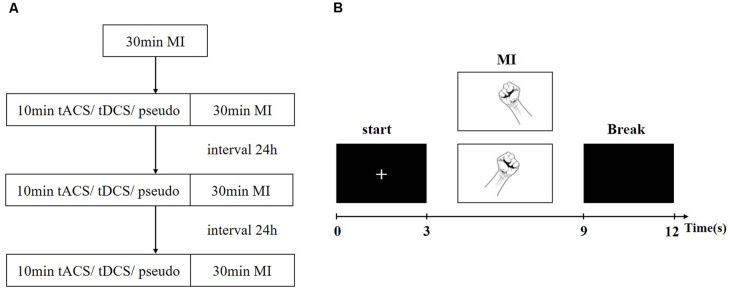
Experiment paradigm. (A) The experimental flow chart. (B) The Single-trial experiment process.